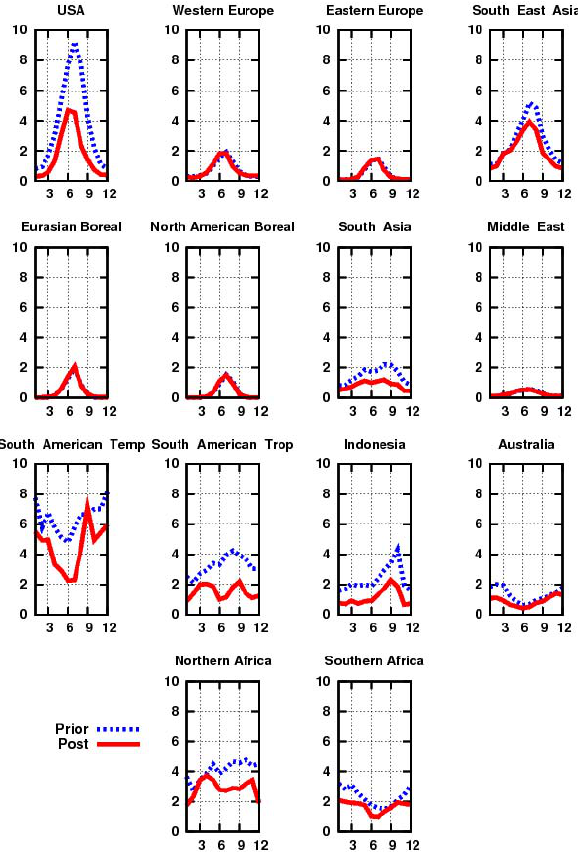
Fig. 5. Times series of prior (in blue) and posterior (in red) HCHO 3-D production by NMVOC for year 2006. Units are TgH- CHO/month.